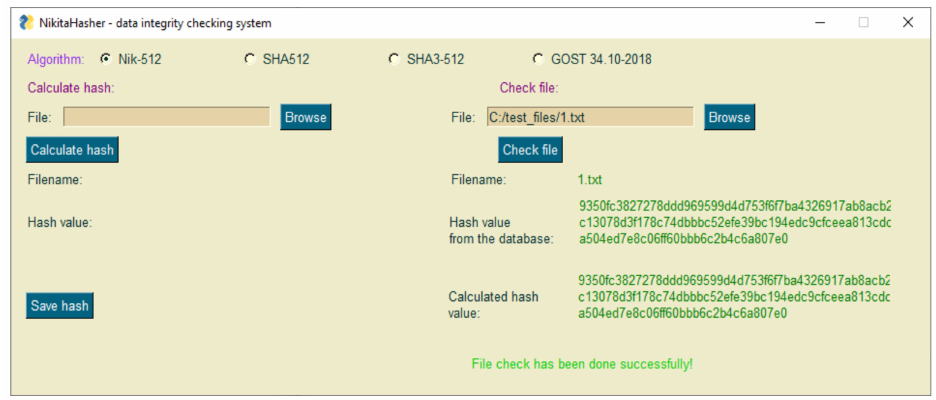
Figure 6. A successful data integrity